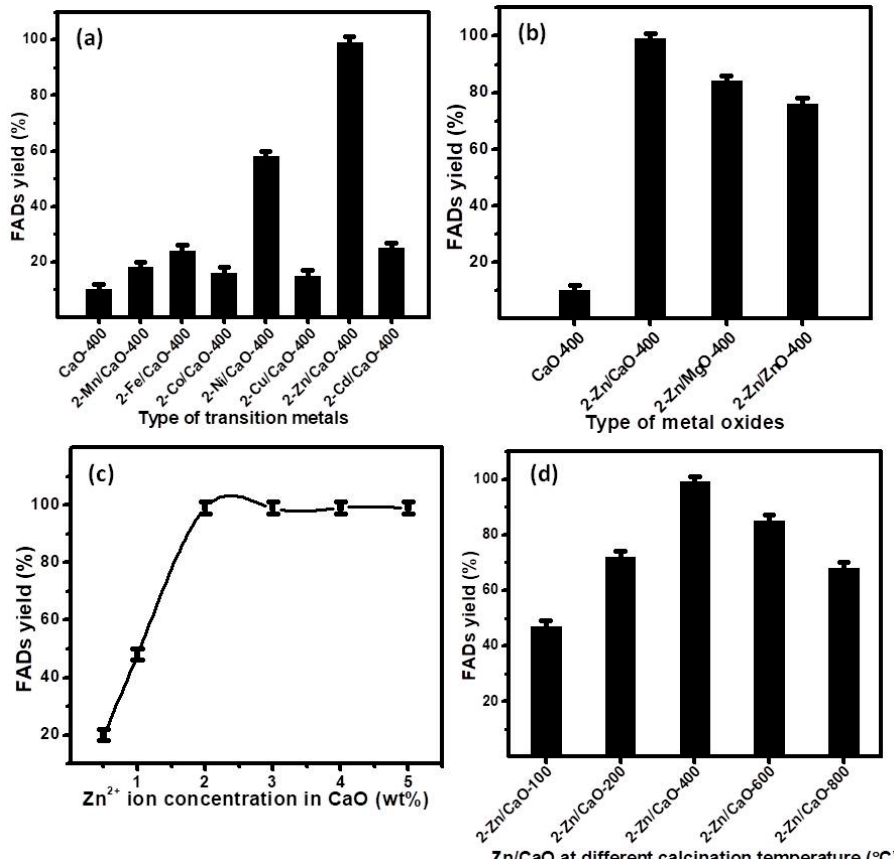
Figure 4. Effect of ( a ) different transition metal doping on CaO, ( b ) Zn ion doping on different metal oxides, ( c ) Zn ion concentration in CaO, and ( d ) calcination temperature in Zn/CaO on the amidation of jatropha oil (JO).